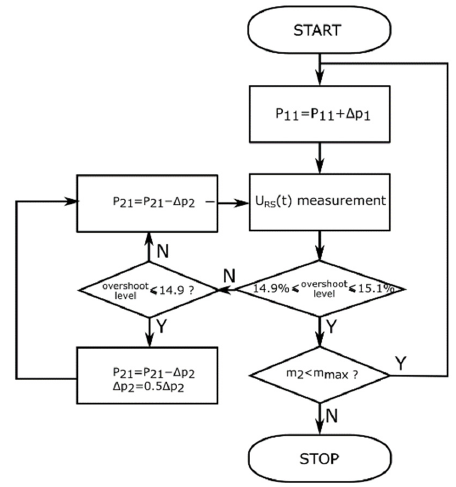
Figure 7. Adjustment algorithm—fine adjustment.